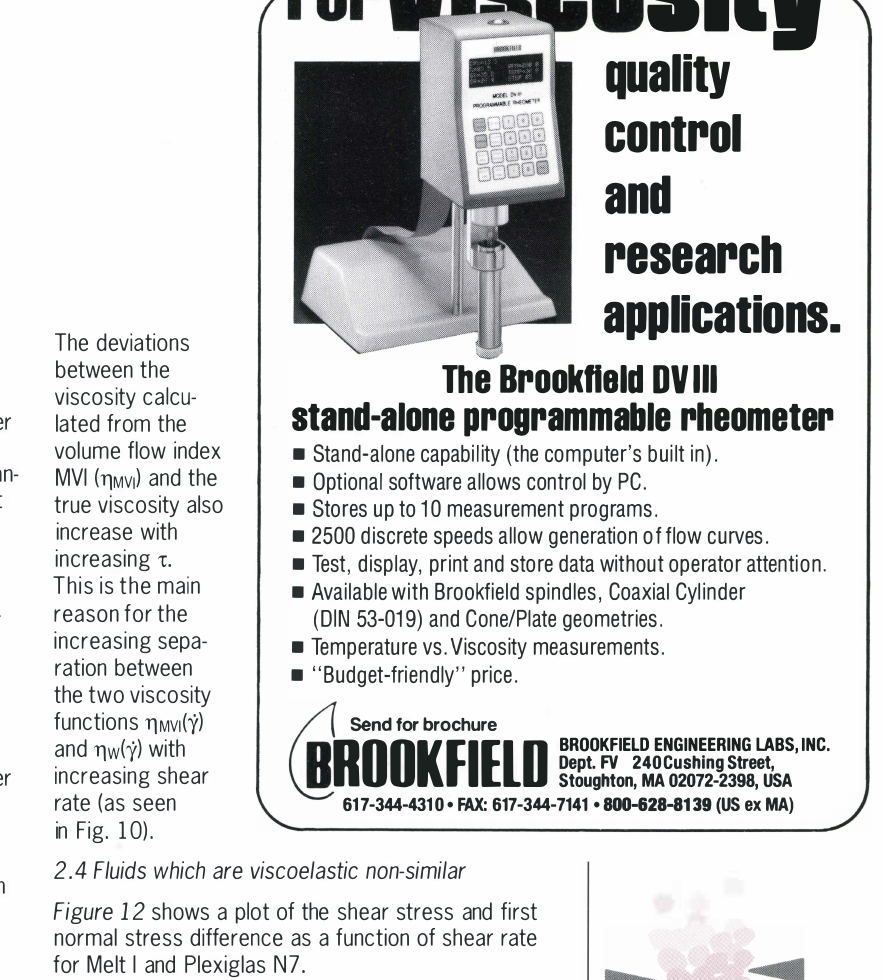
Fig. 12: Shear stress and first normal stress difference functions of polyethylene Melt I and Plexiglas melt